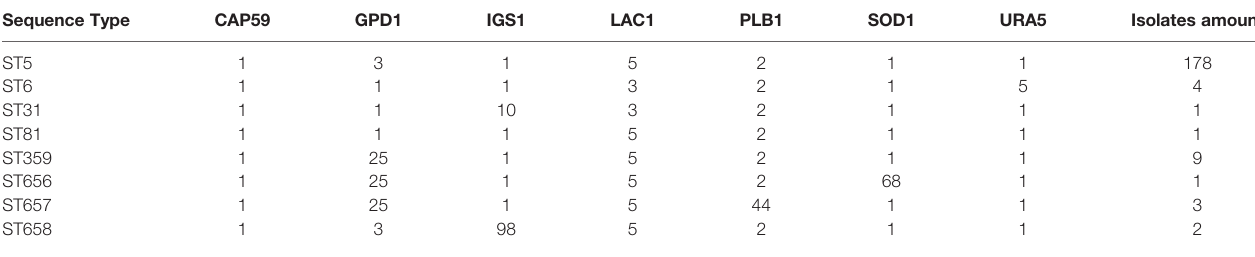
TABLE 2 | Allelic assignments of eight multilocus sequence types in the present